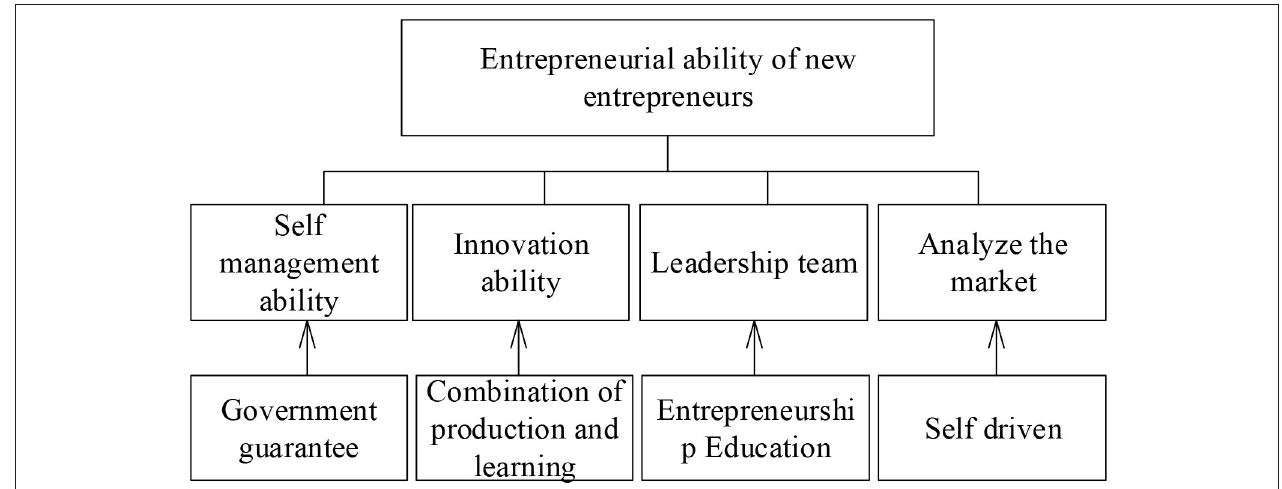
FIGURE 2 | The initial model of training the entrepreneurial ability of new entrepreneurial talents.